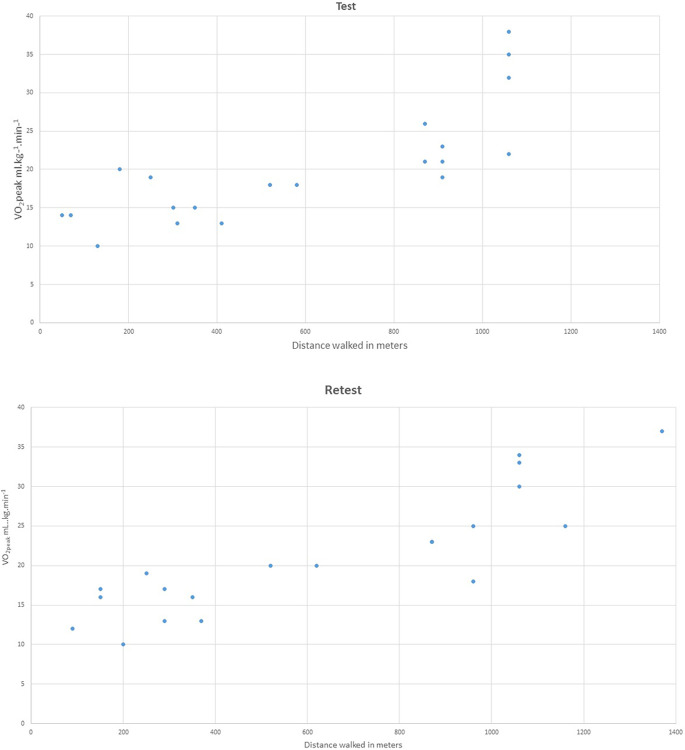
Scatterplot distance walked in meters and VO2peak mL.kg.min-1 test and retest.